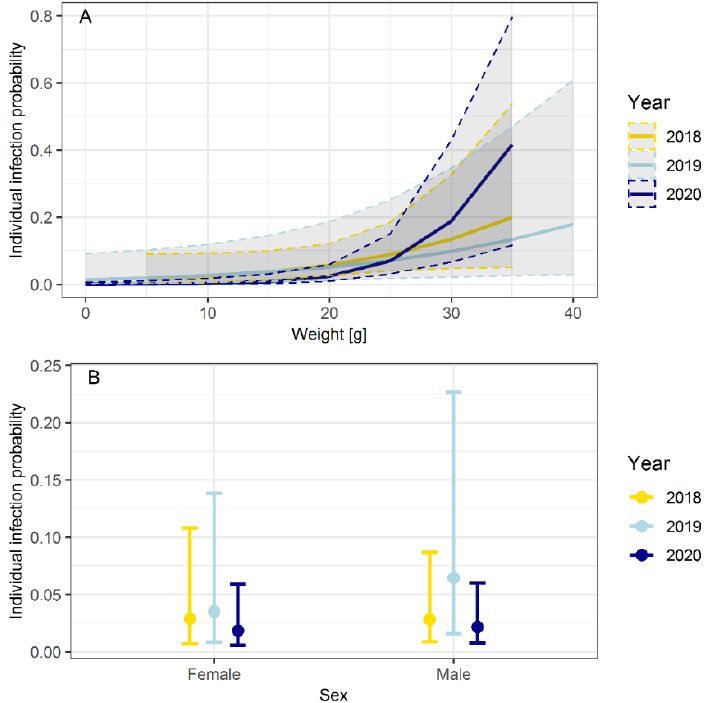
Figure 3. Potential influence of ( A ) body weight and ( B ) sex on individual infection probability. Results are based on lipl32 -qPCR-positive animals. Only animals with sex determination ( n = 1751) were analyzed for influence of sex on the individual infection probability. Table 3. Results of generalized linear mixed modelling with binomial error distribution showing the impact of demographic factors on individual infection probability for each year.